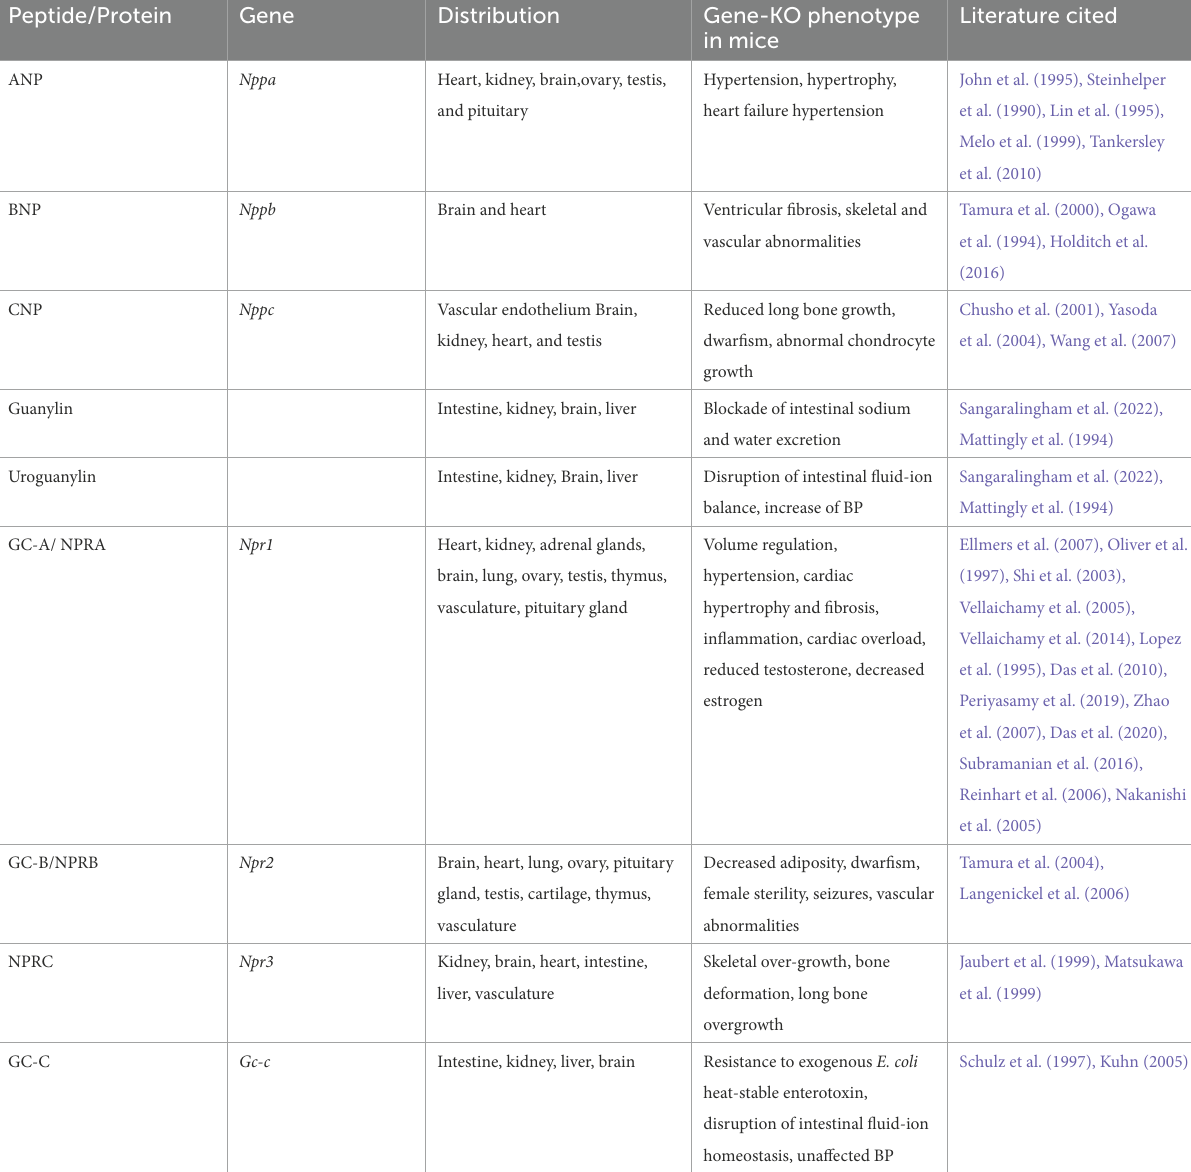
TABLE 1 Nomenclature, distribution, and gene-knockout phenotypes of natriuretic peptides and their specific receptors.